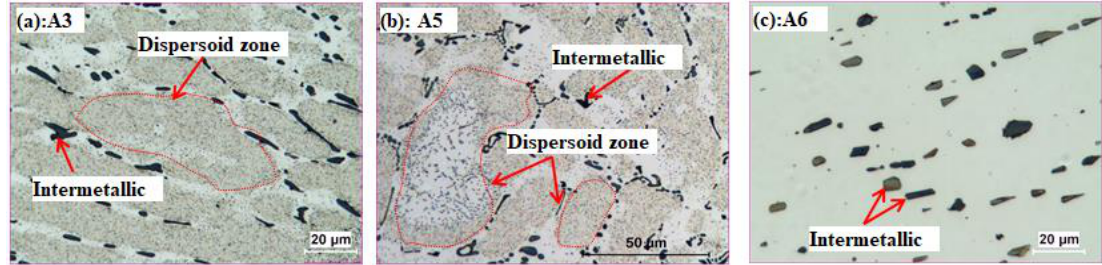
Figure 2. Distribution of dispersoids after single-step heat treatment: ( a ) A3, ( b ) A5 and ( c ) A6.